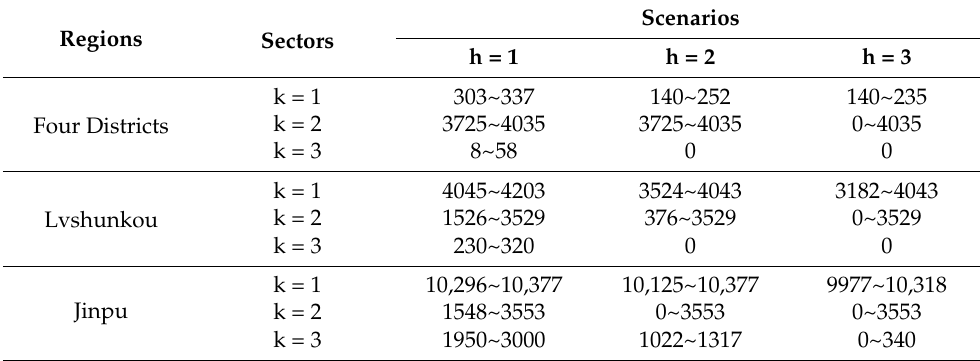
Table 4. Upper and lower bounds of water resource deficit for each sector under different scenarios in period 2 (10 4 m 3